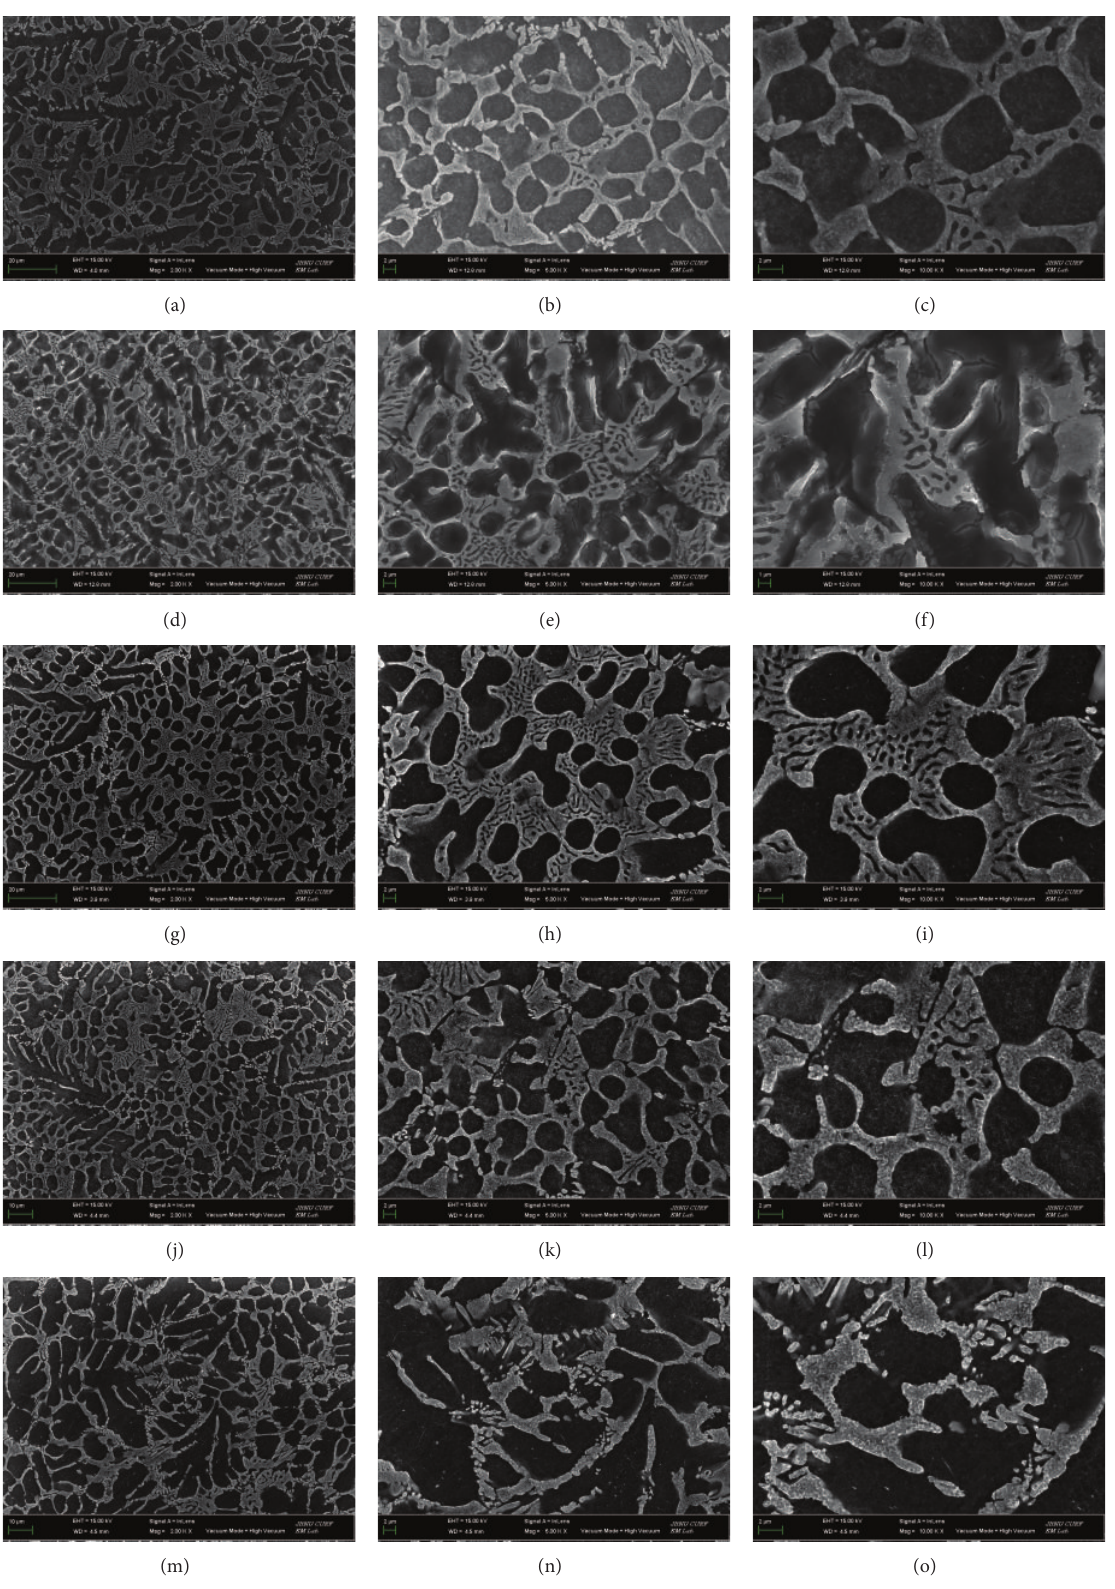
Figure 3: Surface morphology of various heat treated Mg-35Zn-3Ca alloys: (a) AT0 ( × 2000), (b) AT0 ( × 5000), (c) AT0 ( × 10000), (d) AT1 ( × 2000), (e) AT1 ( × 5000), (f) AT1 ( × 10000), (g) AT2 ( × 2000), (h) AT2 ( × 5000), (i) AT2 ( × 10000), (j) AT3 ( × 2000), (k) AT3 ( × 5000), (l) AT3 ( × 10000), (m) AT4 ( × 2000), (n) AT4 ( × 5000), and (o) AT4 ( ×